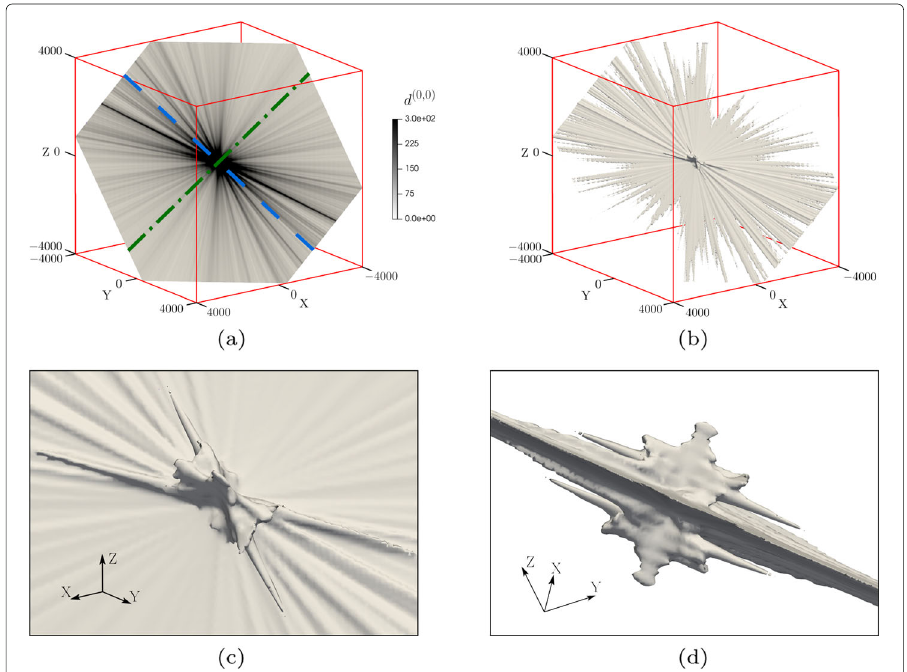
Fig. 15 Correlation d ( 0,0 ) in the central part of the correlation space (cf. Fig. 14a). The unit of the axes in ( a ) and ( b ) is the magnitude of the Burgers vector b . The slice of the pair correlation d ( 0,0 ) on the image of the slip plane in distance space is shown in ( a ). The dashed blue line indicates the direction of the Burgers vector, i.e. the screw direction. The dash-dotted green line shows the edge direction. Surface with constant correlation of 75 ( b ). Zoom of the center of the contour plot ( c ). Rotated view of the central part of the contour plot, parallel to the slip plane ( d